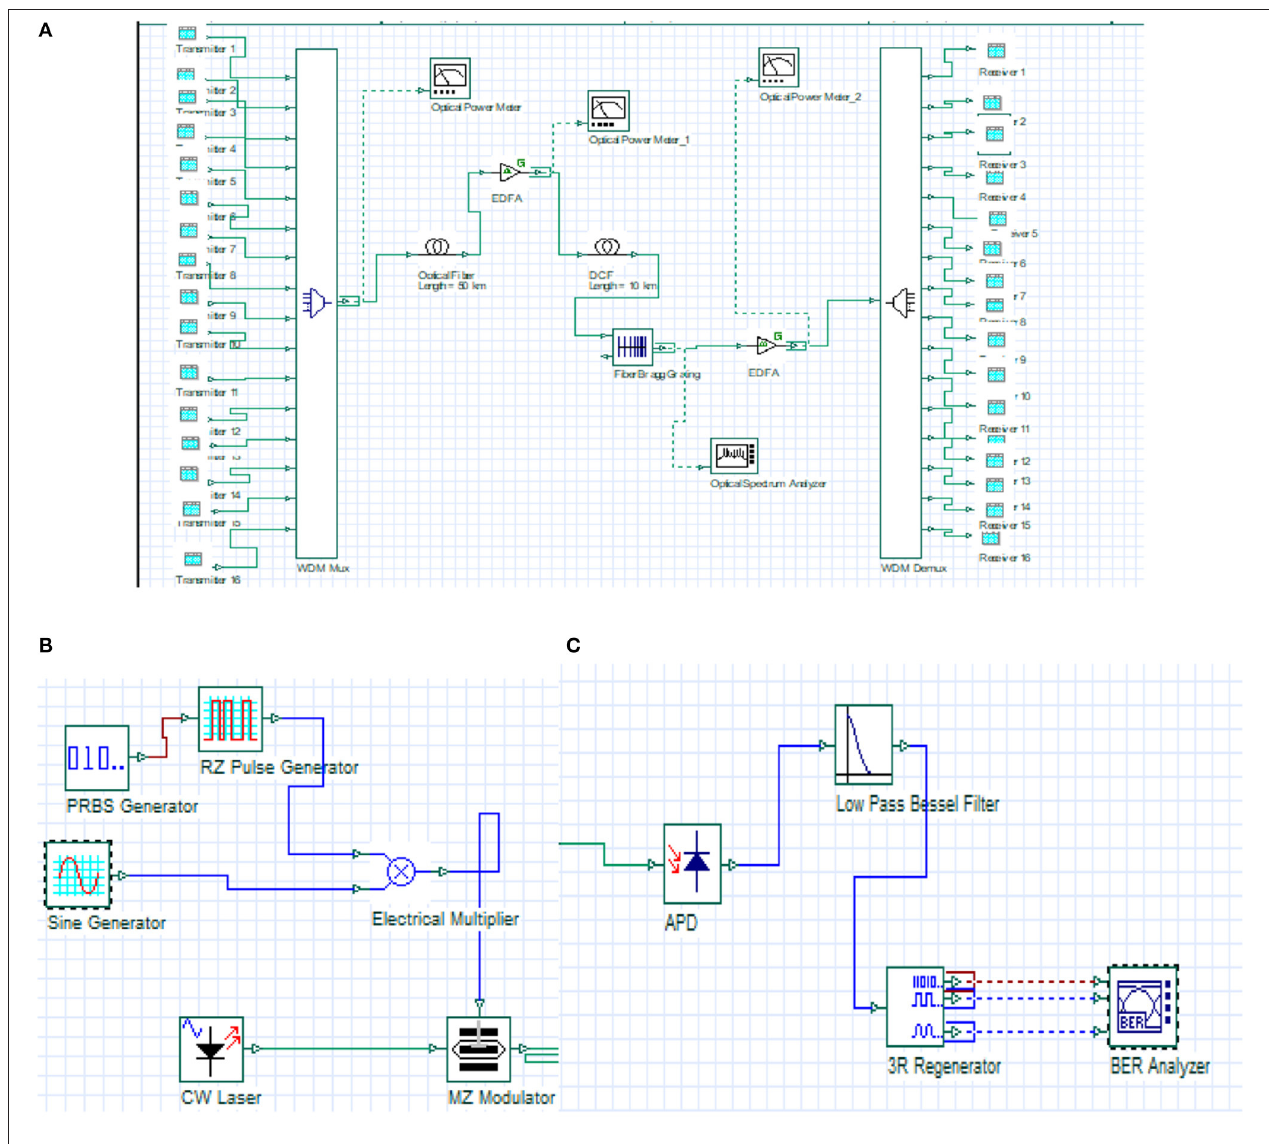
FIGURE 2 | Schematic representation of the simulation layout of the 16/160-Gbps WDM-RoF system, transmitter, and receiver subsystem. (A) The layout of the 16/160-Gbps WDM-RoF system. (B) Transmitter subsystem. (C) Receiver